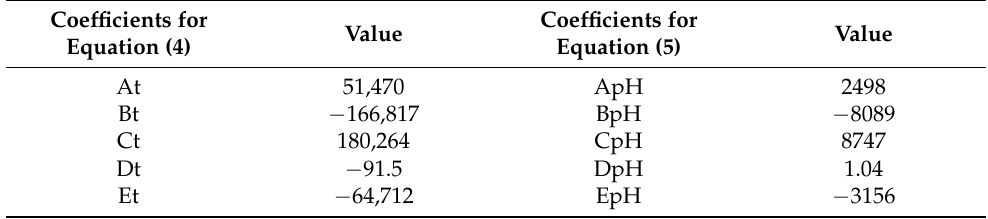
Table 2. Fitted coefficients used in Equations (4) and (5) when using the optimal wavelengths of 525, 537, 581 and 611 nm.